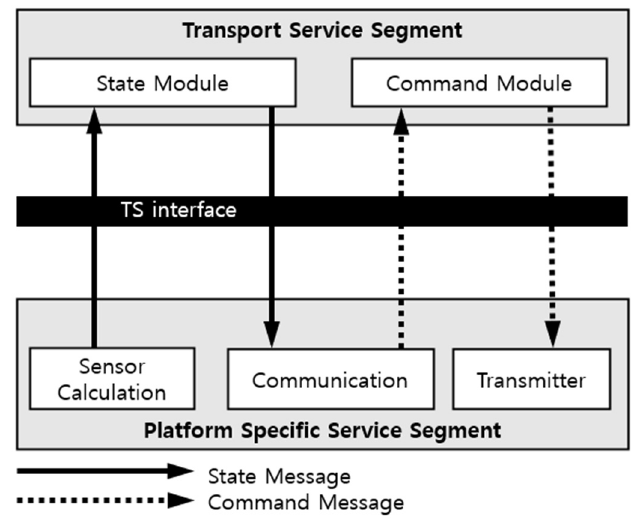
Figure 8. Data flow between TSS and